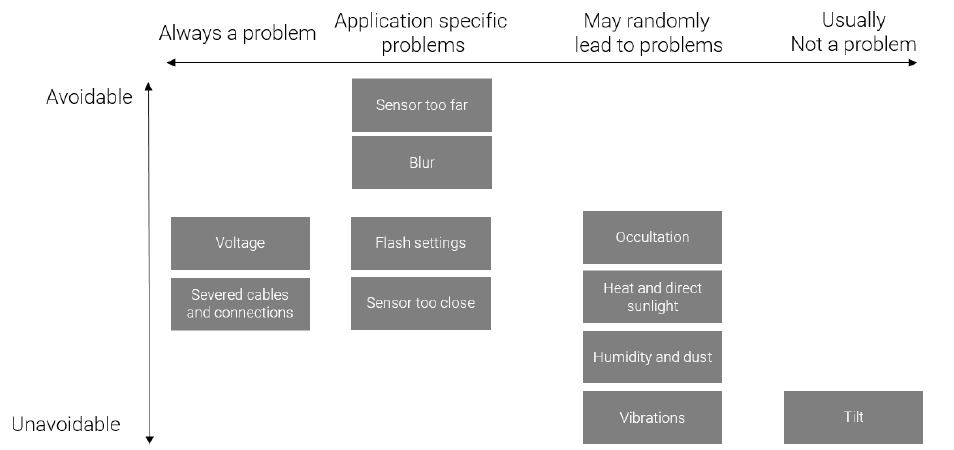
Figure 13. Synthesis of the acquisition parameters. The horizontal axis describes how crucial a parameter is to the acquisition. The vertical axis describes the difficulty in controlling this